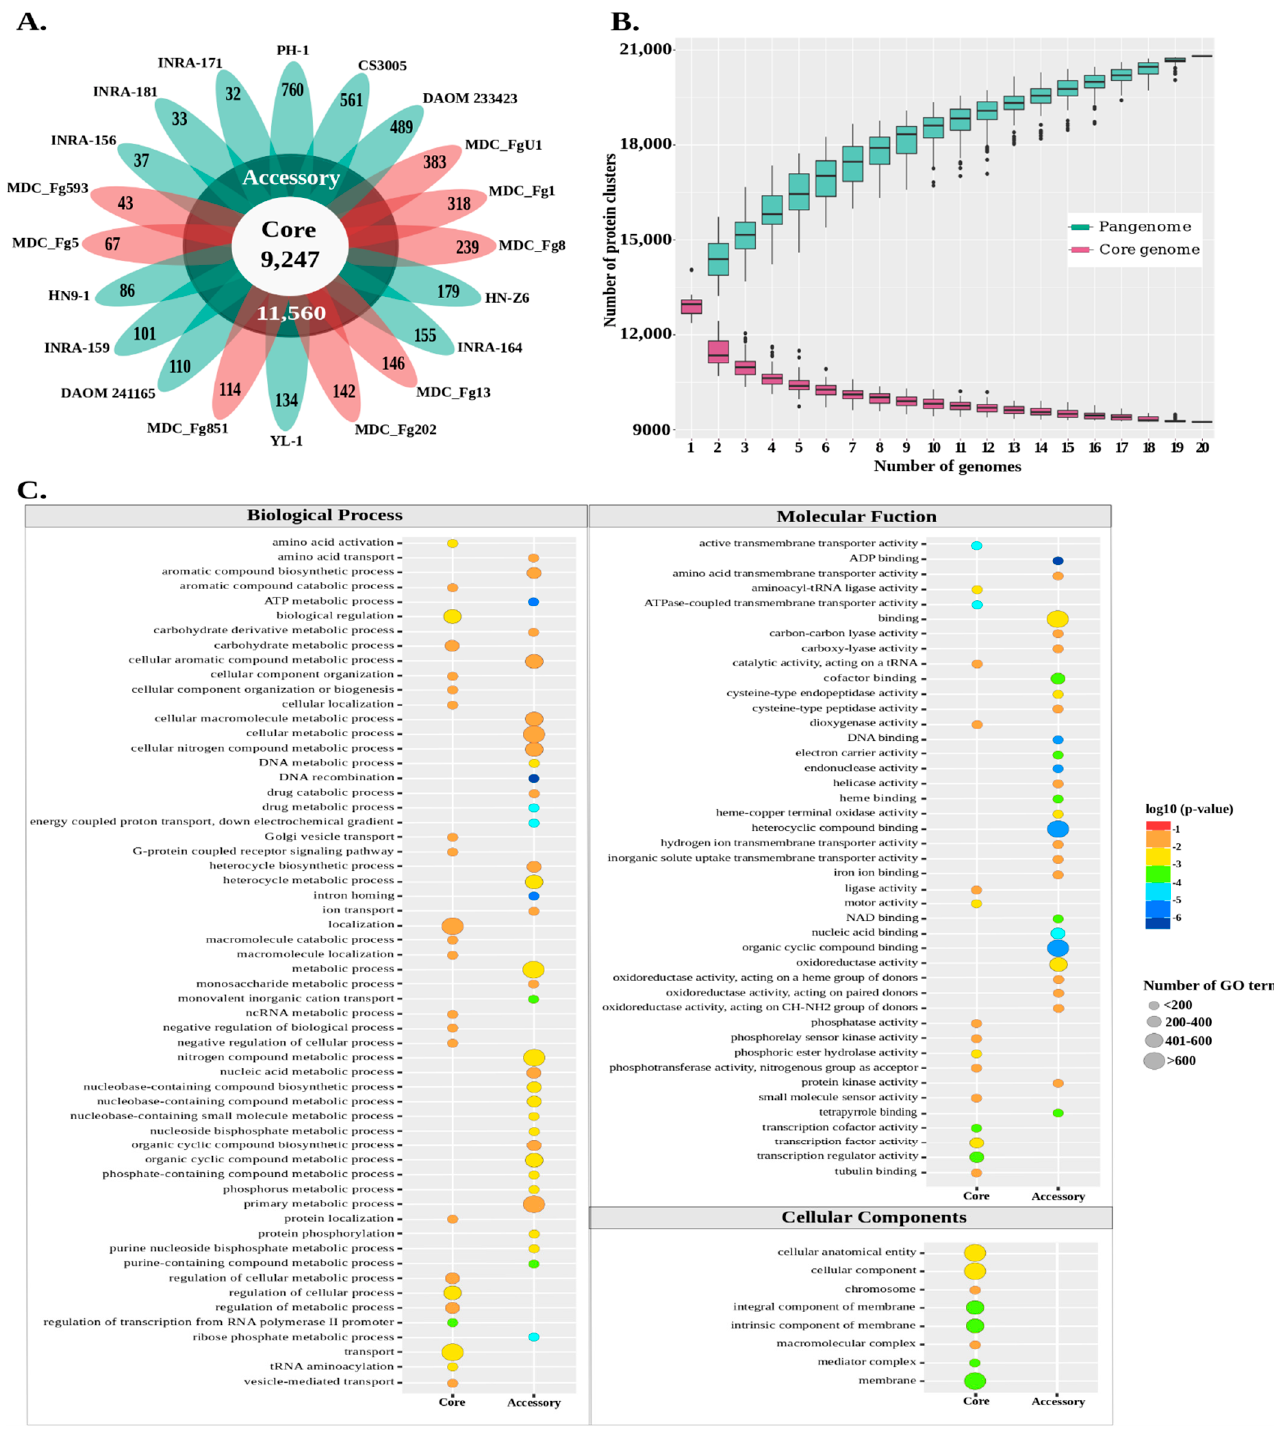
Figure 1. Structure and function of the F. graminearum pangenome. ( A ) The flower plot displays the number of core proteins (in the center) and accessory proteins (in the annulus), including the singletons (in the petals), encoded by the genome of 20 F. graminearum strains. ( B ) The F. graminearum pangenome accumulation curve is depicted with turquoise boxplots, indicating the number of accessory proteins discovered with the sequential addition of new genomes. The purple boxplots illustrate the number of core proteins discovered with the sequential addition of new genomes. ( C ) The density plot depicts the functional enrichment of the core and accessory F. graminearum genomes. Enriched GO terms belonging to biological processes, molecular functions and cellular components are presented. The color of the circle represents the statistical significance of the enriched GO terms. The size of the circles represents the number of occurrences of the corresponding GO